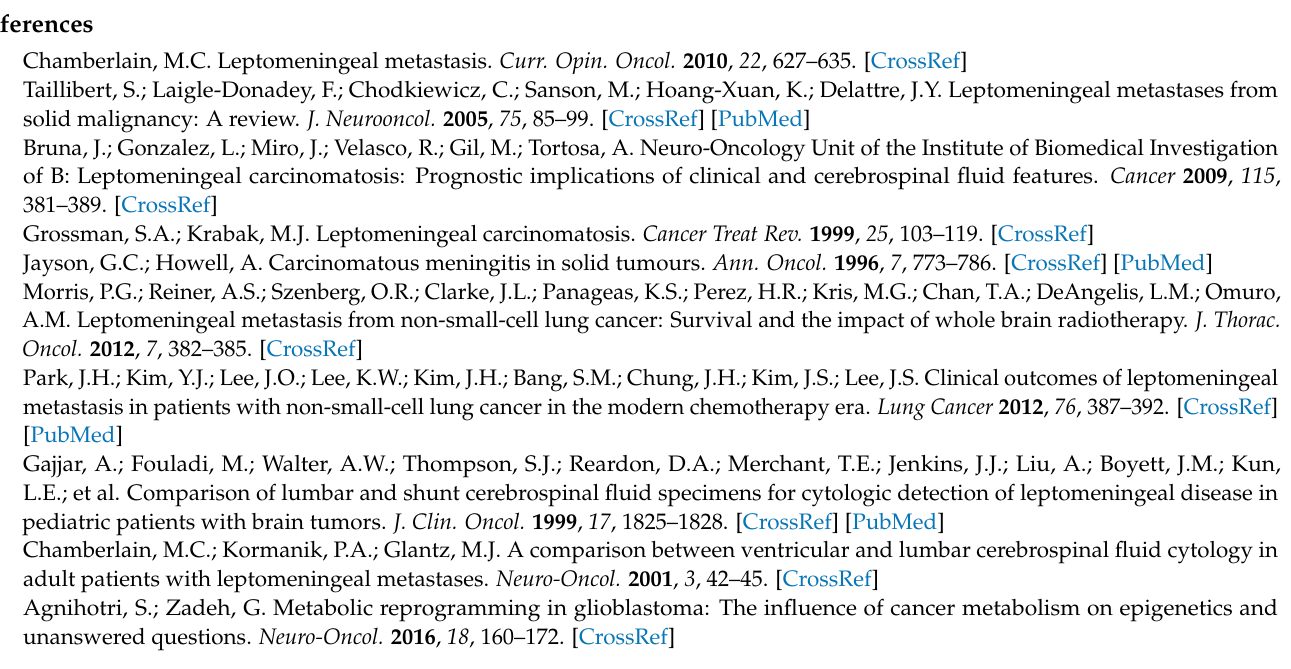
mentary Table S3: Cerebrospinal fluid Protein analyses, Supplementary Table S4: Cerebrospinal fluid Protein enrichment pathway (GO), Supplementary Table S5: Cerebrospinal fluid Protein enrichment Table S7: The original raw data of